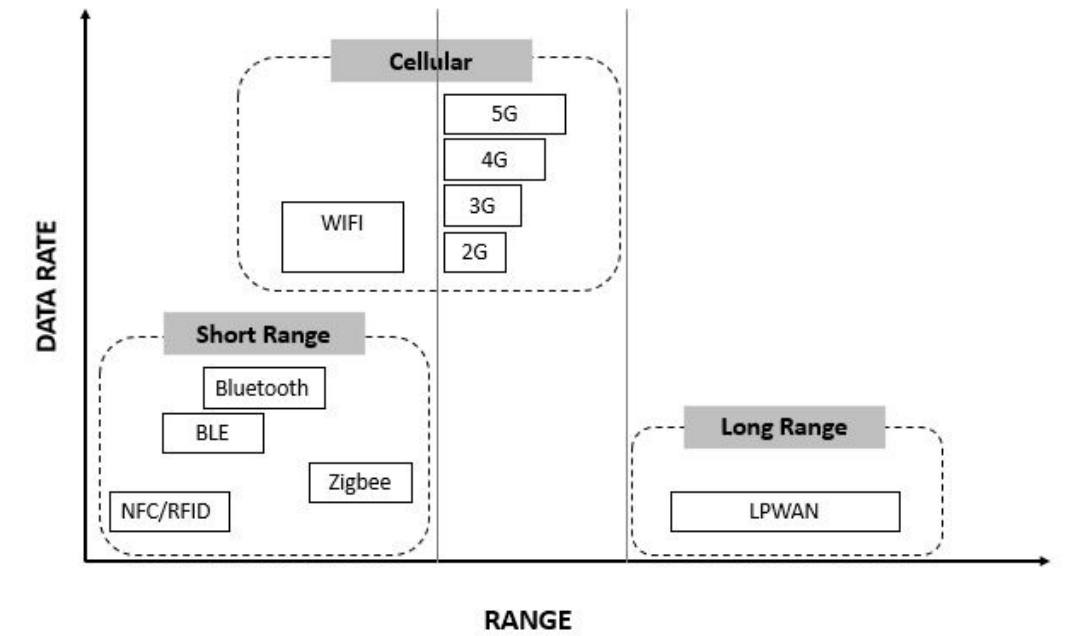
Figure 1. Data rate versus range in wireless networks. Source: [35].